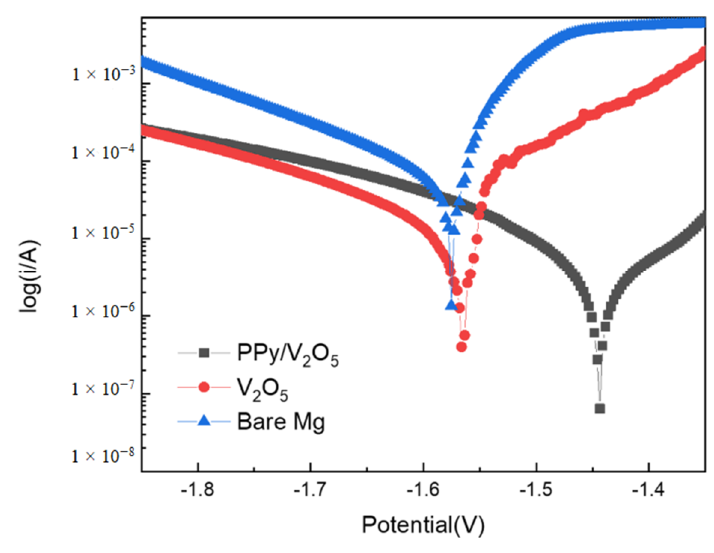
Figure 5. Tafel curves of bare Mg, V 2 O 5 /Mg and PPy/V 2 O 5 /Mg.